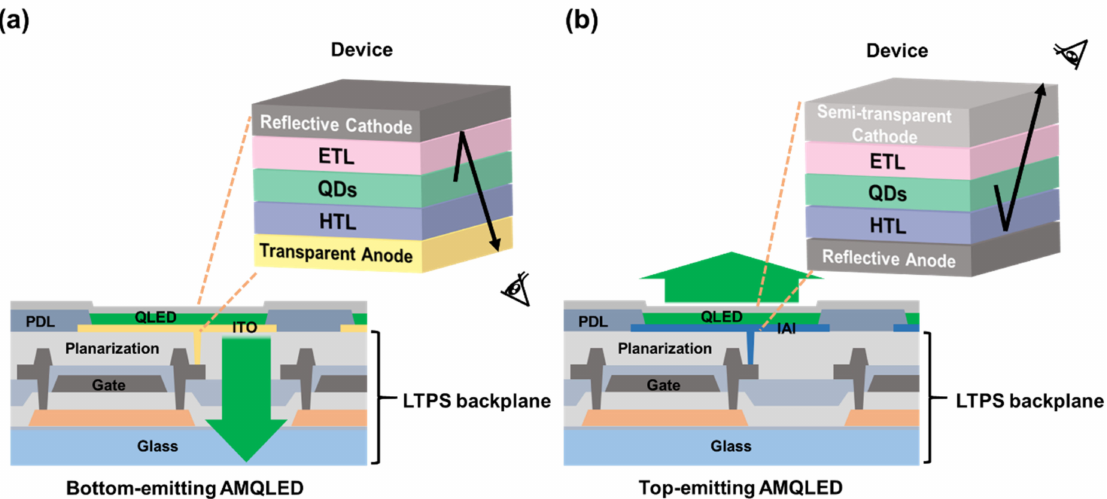
Figure 2. ( a ) AMQLED with a bottom-emitting structure. The light emission intensity is determined by the aperture ratio restricted by the pixel driving circuit. ( b ) AMQLED has a top-emitting structure, which offers a larger opening and, thus, more efficient emission than the bottom-emitting